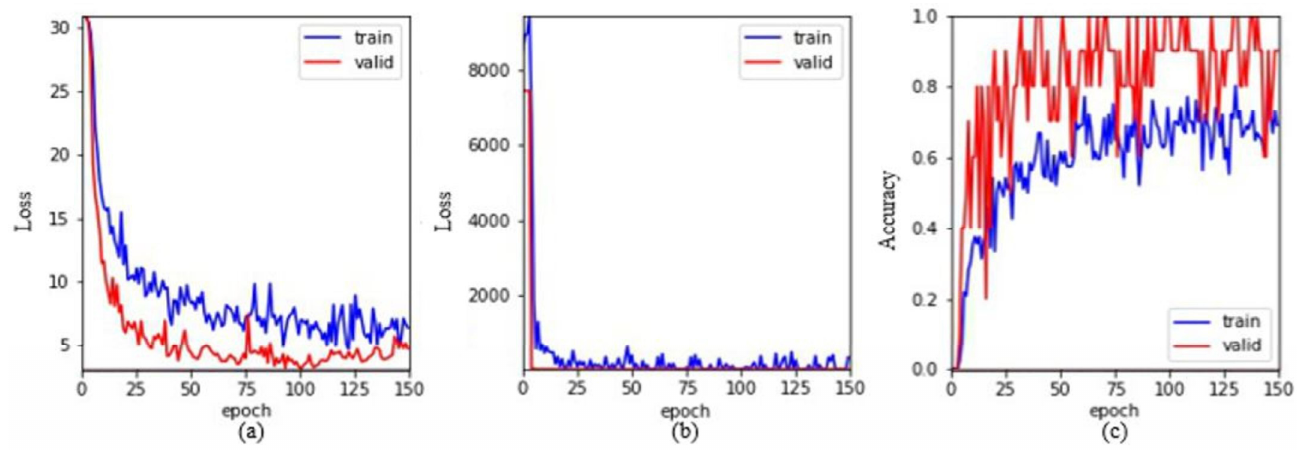
Figure 4. Wrist keypoint training. ( a ) The mean square error (MSE) loss graph of the heat map regression. ( b ) The MSE loss graph of the image coordinates converted from the heat map. ( c ) The accuracy of the test and training data.